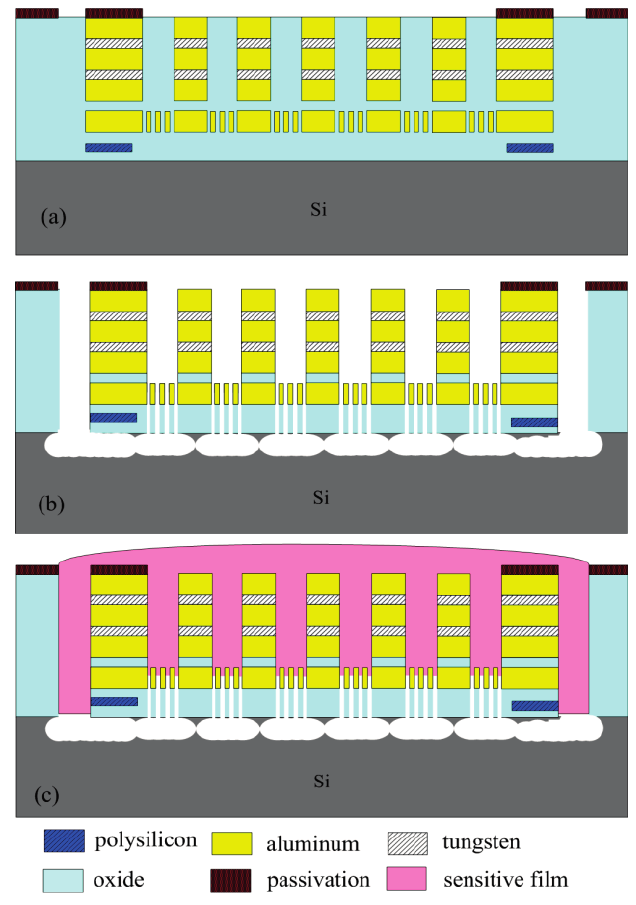
Figure 6. Fabrication process of the methanol sensor: ( a ) after the CMOS process; ( b ) etching the sacrificial layer; and ( c ) coating the sensitive